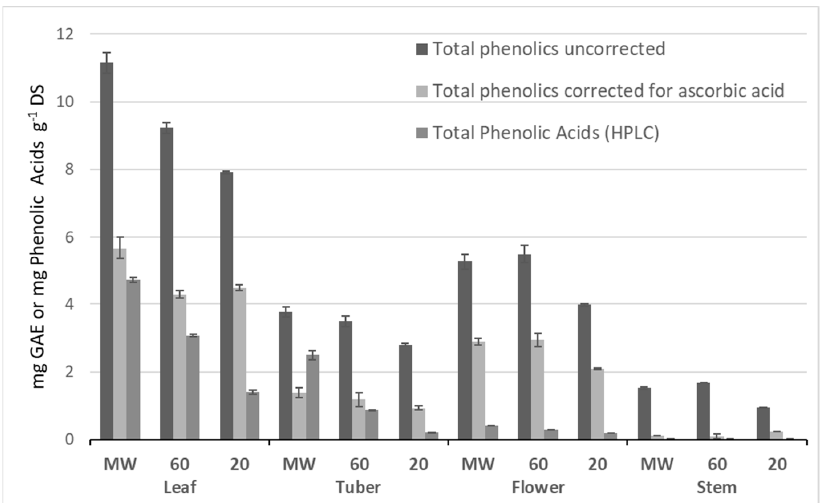
Figure 2. Distribution of total phenolic content (TPC) in Jerusalem artichoke plant organs measured as mg gallic acid equivalents (GAE) per g dry substance (DS) in ethanol extracts. Plant organ extracts prepared at three heating levels (MW, microwaving; 60, 60 ◦ C; and 20, 20 ◦ C). TPC is shown both